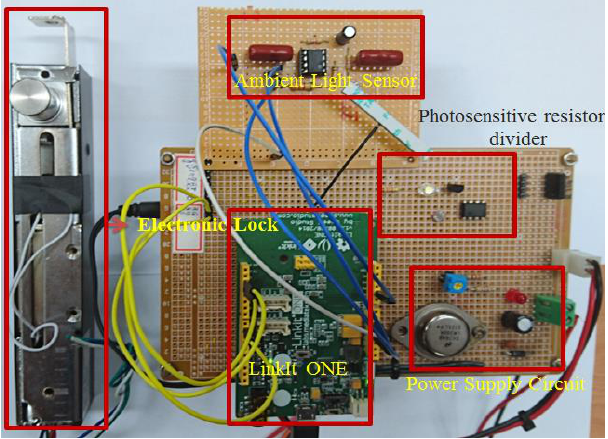
Figure 7. The complete hardware in our work.